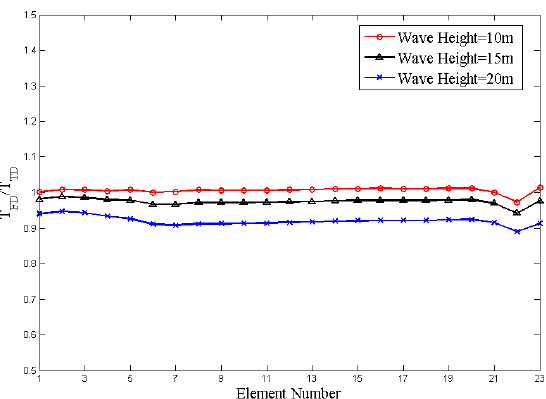
Figure 16. The ratio of dynamic tension amplitude in the frequency domain and time domain under a regular wave.